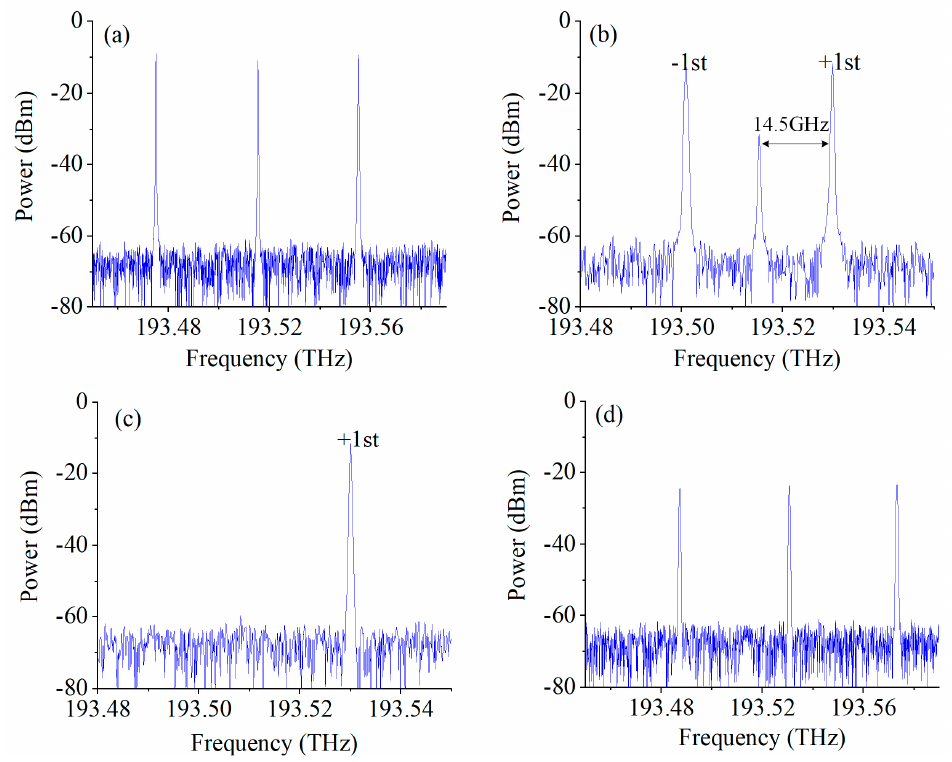
Figure 2. Measured optical spectra of ( a ) the signal OFC, ( b ) the CS − DSB signal, ( c ) the +1st order sideband, and ( d ) the local OFC.